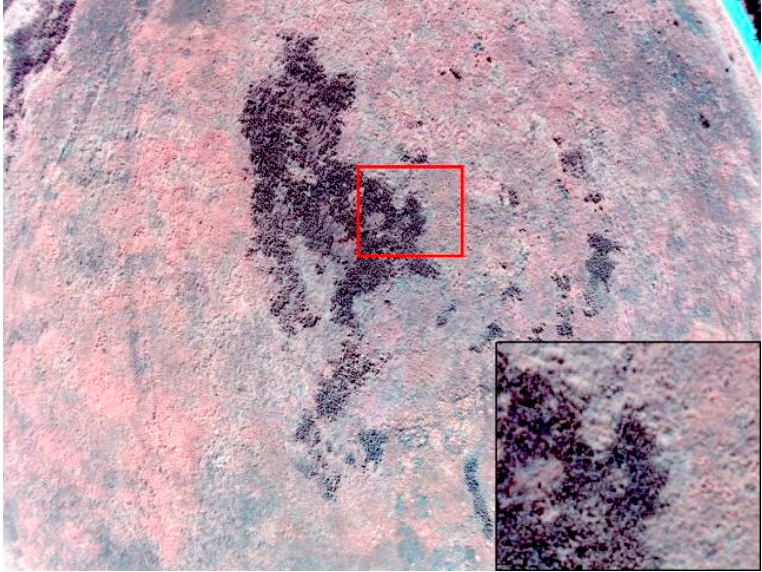
Figure 3 . A raw image acquired by the UAV on 22 April 2016 depicting weed patches (in dark) in the centre of the study area (not in scale).